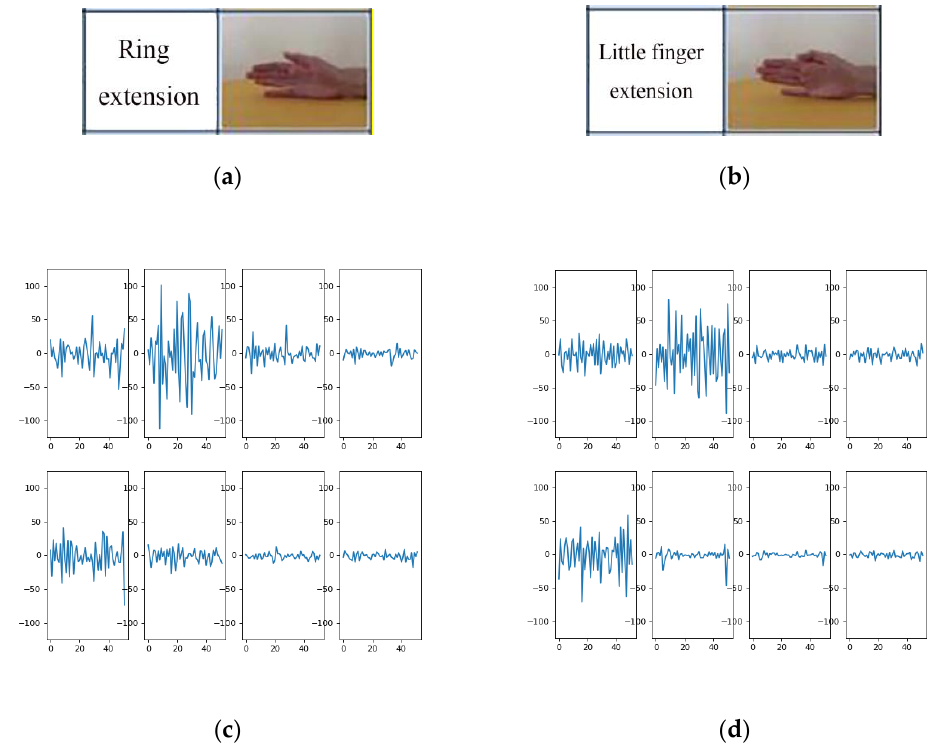
Figure 12. Parts ( a ) and ( b ) represent pictures of two di ff erent gestures in exercise A, Parts ( c ) and ( d ) Figure 12 . Parts ( a ) and ( b ) represent pictures of two different gestures in exercise A, Parts ( c ) and ( d ) show the spectrum diagrams of the sEMG signal generated by ( a ) and ( b ) show the spectrum diagrams of the sEMG signal generated by ( a ) and ( b ) respectively.